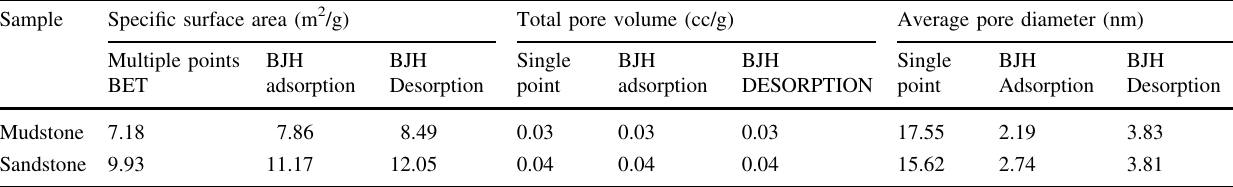
Table 2 Surface structure and pore distribution of mudstone and sandstone in underground reservoir Sample Specific surface area (m 2 /g) Total pore volume